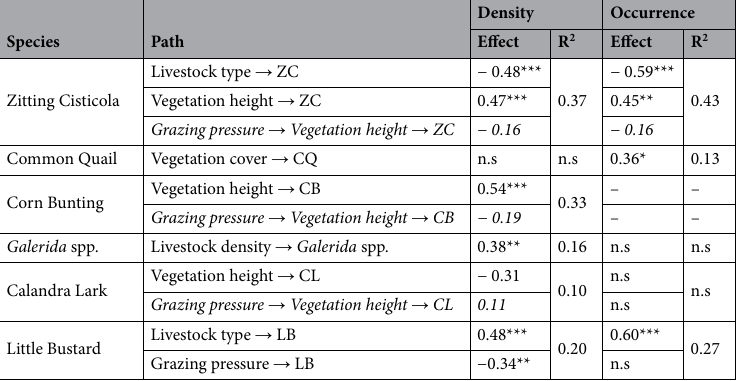
Table 3. Standardized effects of the significant paths for the density and occurrence of each target species (Supplementary Fig. S2): Zitting Cisticola (CZ), Common Quail (CQ), Corn Bunting (CB), Galerida spp., Calandra Lark (CL) and Little Bustard (LB). Standardized path coefficients are shown according to the criteria: *** p < 0.01; **0.01 < p < 0.05; *0.05 < p < 0.10; n.s. is used for paths with p > 0.1. The indirect effects are shown in italic and were obtained by multiplying the partial standardized path coefficients. Since the Corn Bunting was present in all parcels, the occurrence model was not